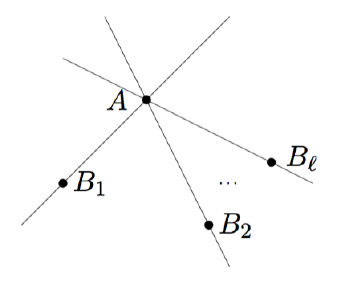
Figure 2 . Intersecting